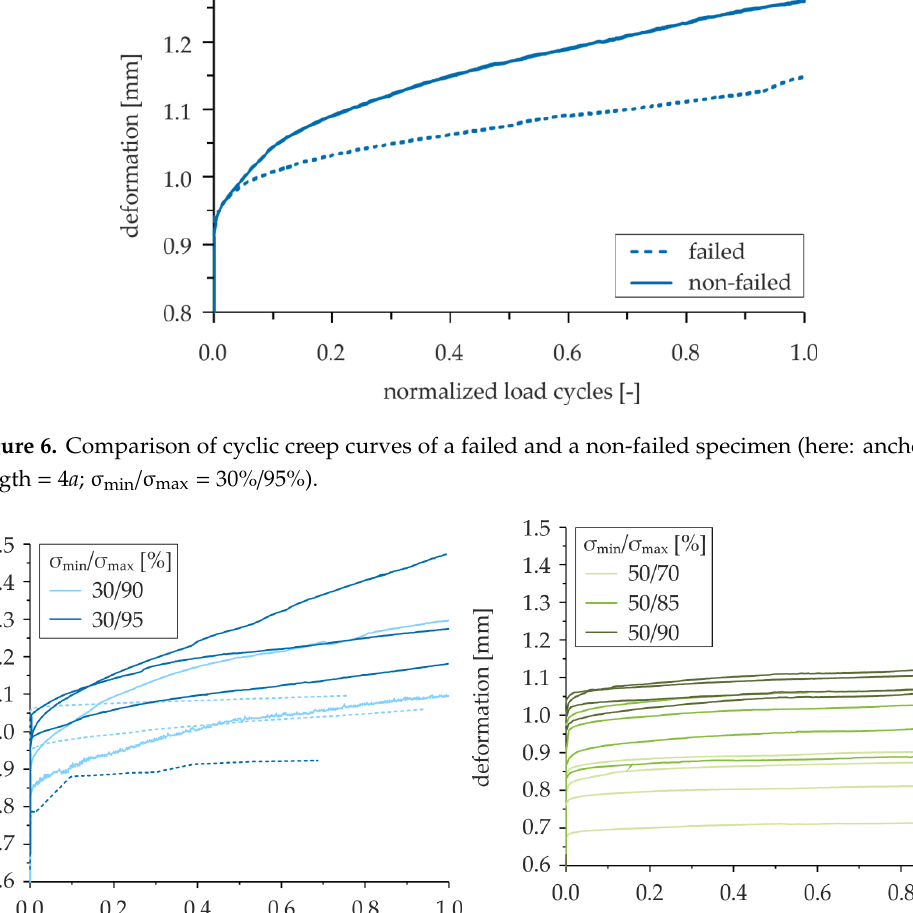
Figure 8. Comparison of normalized cyclic creep curves depending on the amplitude (here: anchorage length = 3 a ). 3.3.3. Dependence on Anchorage Length Now, the influence of the anchorage length on the deformation is regarded. Therefore, the four different investigated anchorage lengths were compared at several load levels. Figure 9 shows an example of the cyclic creep curves at a load level of 50/85. The comparison of the creep curves at other load levels is shown in Figure A5. Again, failed specimens are marked by dashed lines.